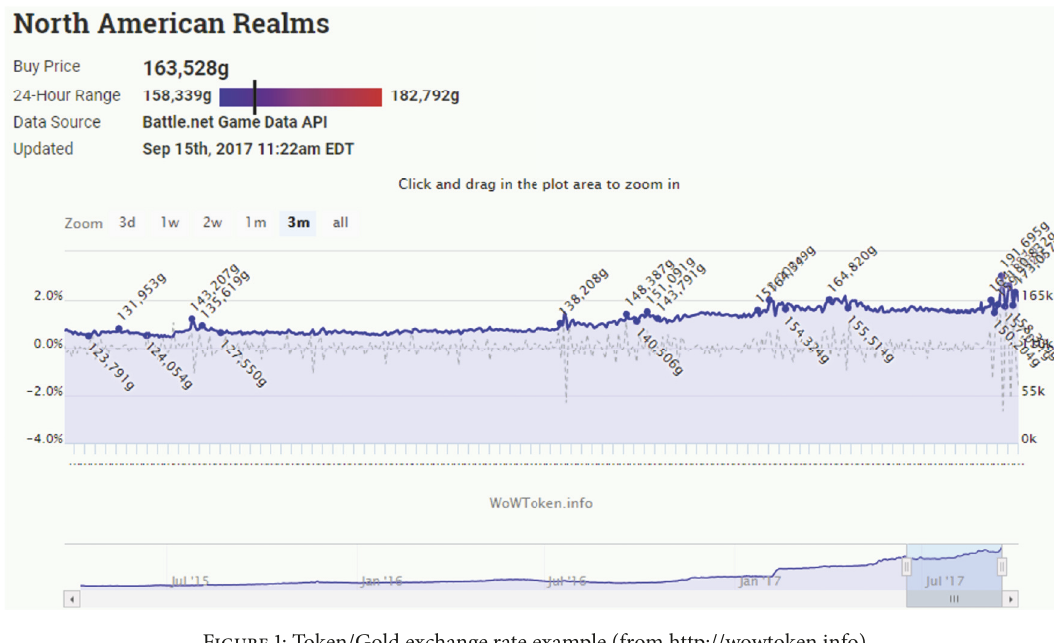
Figure 1: Token/Gold exchange rate example (from http://wowtoken.info).